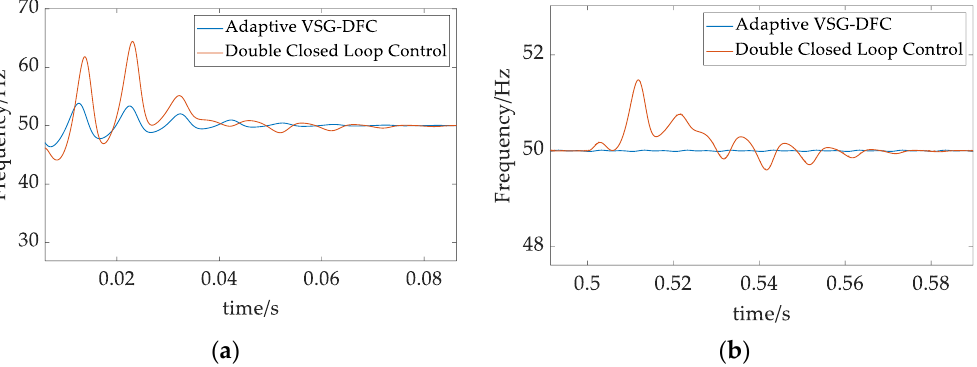
Figure 17. Output frequencies of MMC-RPC under two control methods. Partial diagram of output frequencies by setting: ( a ) MMC-RPC is put into operation, ( b ) sudden load change.